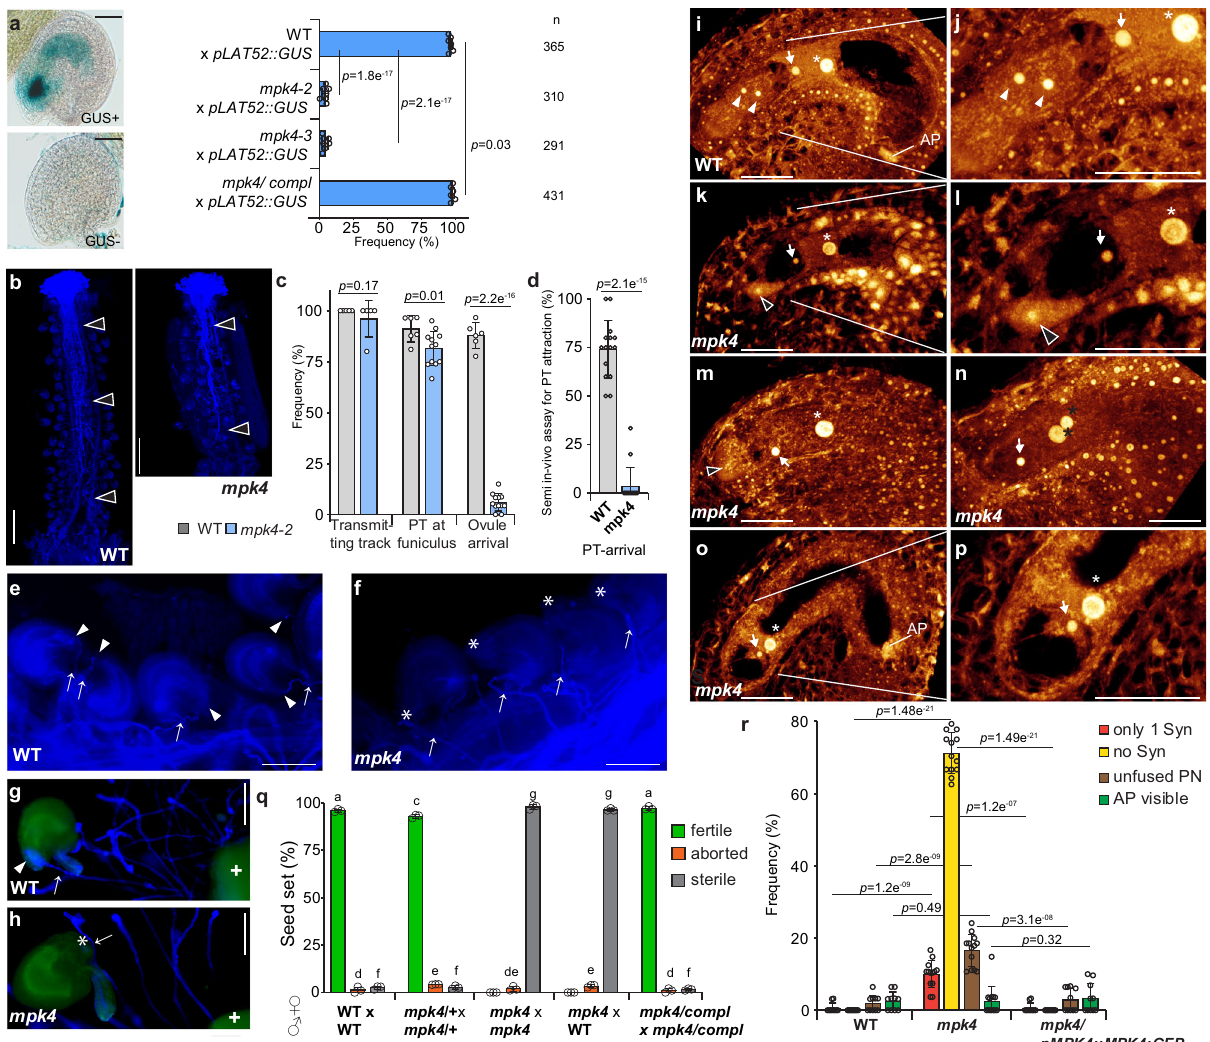
+ Fig. 1 Premature synergid degeneration in mpk4 . a Pollen tube (PT) attraction assay in wild-type (WT), mpk4-2 , mpk4-3 , and the complementation line expressing pMPK4::MPK4GFP in mpk4-2 . Plants were pollinated with pollen of pLAT52::GUS -expressing plants. PT attraction was analyzed 24 hr after pollination. Scale bars, 30 µ m. b – c, e – f PT growth assay through the transmitting tract to the ovules in WT and mpk4-2 by aniline blue staining ( b , scale bar 0.5 mm; e , f , scale bar 0.1 mm). WT pollen was applied and the growth through stigma, transmitting track towards the ovule was monitored for 24 h. Presented are the results of the 5 biological replicates ( n = 26). white-edged black arrowhead, PTs; white arrowhead, PT arrived at the FG; white asterisk, unguided PT; white arrow, PT on the funiculus/ close to the ovule. Error bars show ± SD. ( d , g , h ) Analysis of the short-track PT attraction ability in WT and mpk4 by semi-in vivo PT assay followed by PT calco fl uor white staining. WT pollen were applied on WT-stigmas and ovules of WT ( g ) and mpk4 ( h ) were placed below the stigma decapitation site. The PT attraction ability was analyzed after 6 h. White plus refers to the decapitated WT stigma; white arrowhead, PT arrived at the FG; white asterisk, unguided PT; white arrow, PT on the funiculus/ close to the ovule. Presented are the results of 3 biological replicates comprising a total of 69 ovules in WT and 68 ovules in mpk4 . Error bars show ± SD. Scale bar 0.1 mm. i – p Representative CLSM images of WT ( i – j ) and mpk4 ( k – p ) female gametophytes (FG) 48 h post-emasculation. Depicted are maximum projections of Z-stacks, with a focal plane distance of 1 µ m within a total range of about 20 µ m, animated 3D-projections are provided in Supplementary movies 1-4. k – m FG of mpk4 that shows prematurely degenerating synergids. n – p FG of mpk4 with completely absent synergids. n FG with polar nuclei and without synergids. White arrowhead, synergid; black arrowhead, degenerating synergid; white arrow, egg cell; white asterisk, central cell nucleus; black asterisks, polar nuclei. Scale bars, 30 µ m. q Seed formation in WT ( n = 287), mpk4 / + ( n = 516), mpk4 /- ( n = 331), mpk4 /- x WT ( n = 225) and the MPK4 complementation line ( n = 249). Error bars show ± SD. Statistical signi fi cance was analyzed by one-way ANOVA. Letters indicate signi fi cant differences from the mean ( p ≤ 0.05) within the same category of either fertile, aborted or sterile among the different genotypes. r Morphological characterization of the female gametophytic cells in WT ( n = 314), mpk4-2 ( n = 366) and mpk4 complementation line ( n = 306) 48 h post-emasculation. Error bars show ± SD. Syn, Synergids; PN, polar nuclei; AP, antipodal cells. a , c , d , r Statistical signi fi cance was analyzed by one-way ANOVA. Source data and further statistical analysis are provided in the source data fi